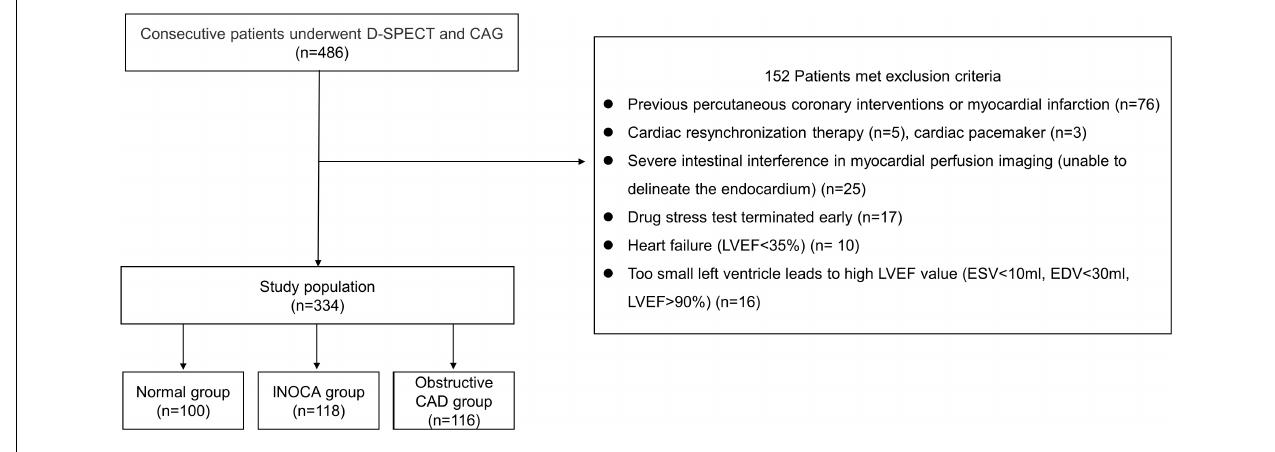
FIGURE 1 | Patient